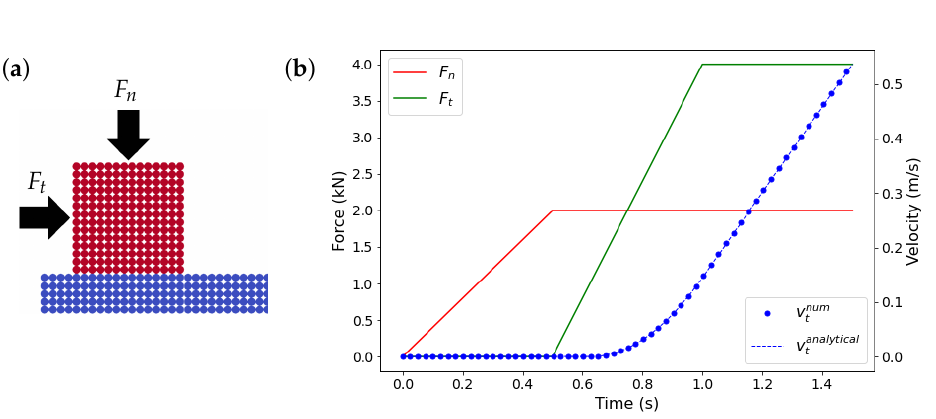
Figure 3. The initial two dimensional model where the slider, in red, is the primary solid body ( a ). The velocity of the slider parallel to the slope ( b ), dots represent the simulations results, and dashed-lines represent the analytical solutions of this problem.